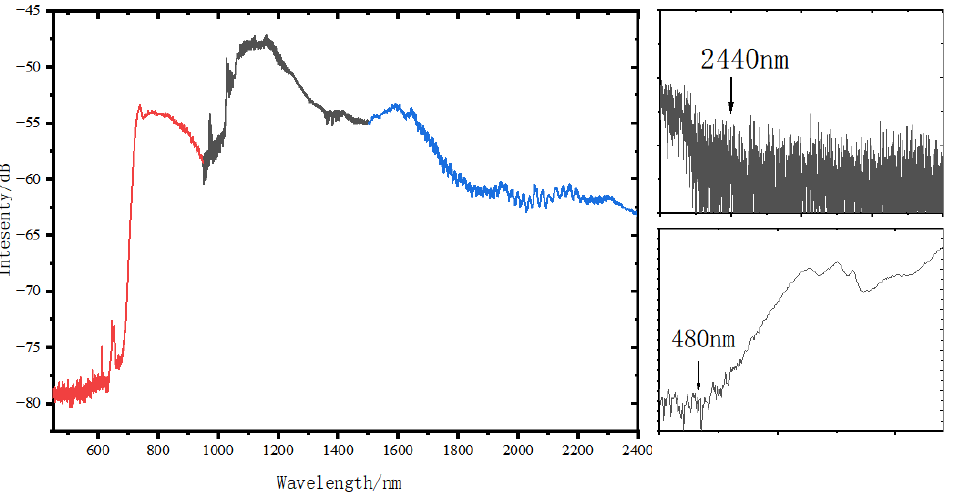
Figure 3. The spectrum of the supercontinuum after 10 m GRIN fiber of output power 22.3 W.